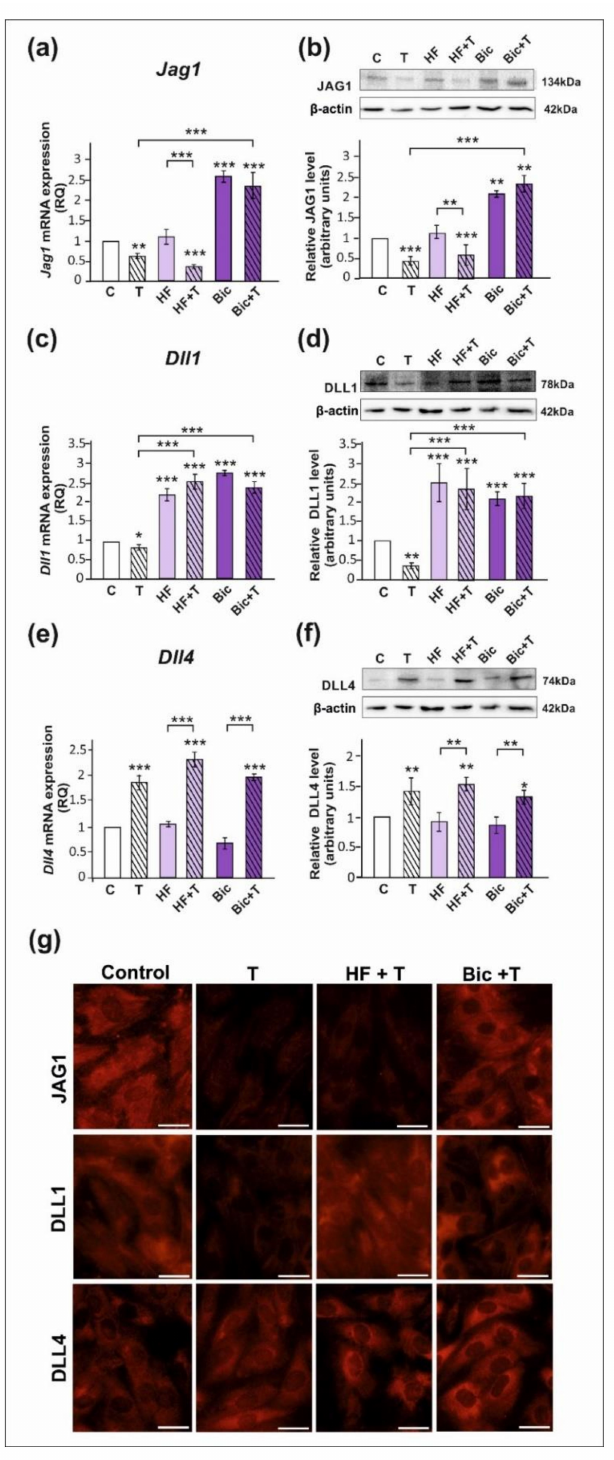
Figure 1. The effect of androgen receptor antagonists on mRNA and protein expression of Jag1 /JAG1, Dll1 /DLL1, and Dll4 /DLL4 in primary rat Sertoli cells. Cells were treated with 10 − 8 M testosterone (T), 10 − 4 M hydroxyflutamide (HF), HF + T, 10 − 6 M bicalutamide (Bic), Bic + T, or vehicle (C) for 24 h. ( a , c , e ) Relative expression of mRNAs (RQ) was determined using real-time RT-PCR analysis. The expression values of the individual genes were normalized to the mean expression of the reference genes. ( b , d , f ) Western blot detection of the proteins. The relative level of studied protein was normalized to β -actin. The protein levels within the control group were arbitrarily set at